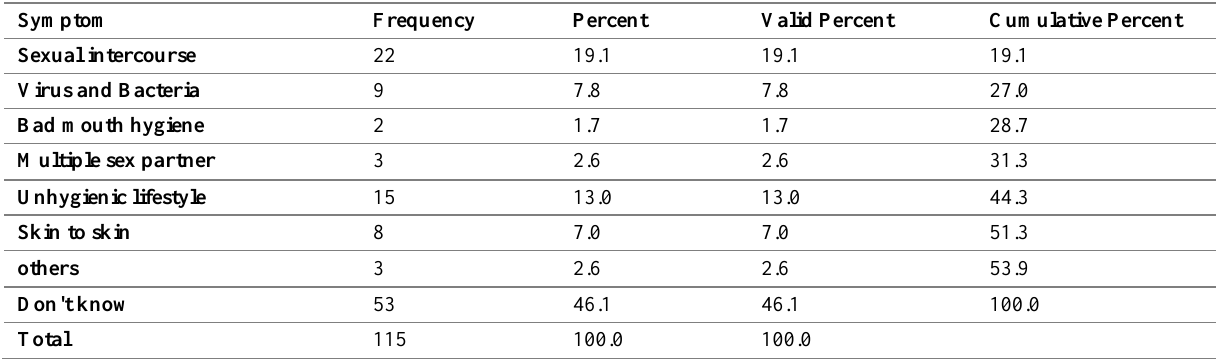
Table 2: Knowledge regarding causes of STDs transmission among slum